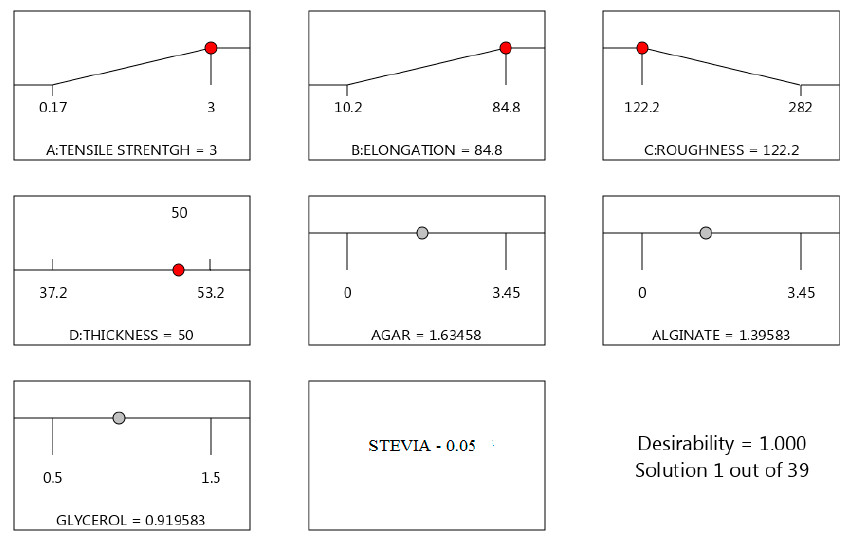
Figure 4. Ingredients and related quantities to obtain a material with good mechanical properties.